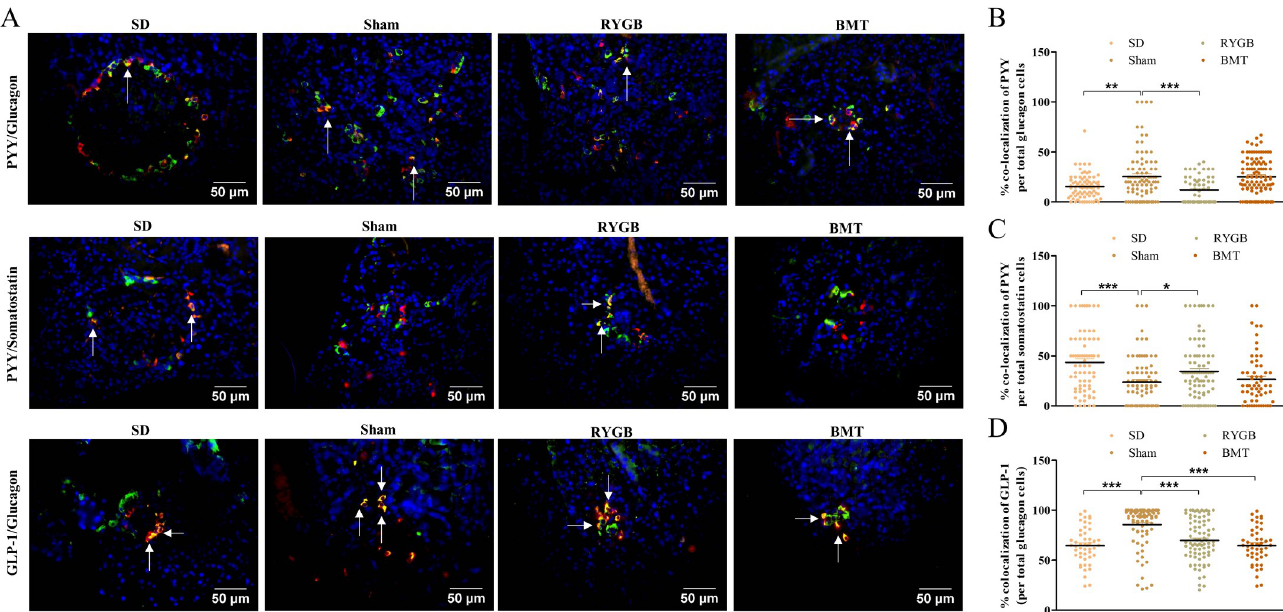
Fig 8. Effects of RYGB, BMT and sham surgery on gut hormone co-localization in islets 8 weeks post-experimental intervention. (A) Representative islet images showing PYY (red) with glucagon & somatostatin (green), GLP-1 (red) with glucagon (green). Nuclei are demonstrated using DAPI staining (blue). Quantification of co-localization of PYY with (B) glucagon and (C) somatostatin, and (D) GLP-1 with glucagon are also shown. Arrows indicate cells that are positive for both PYY and glucagon or somatostatin, and GLP-1 with glucagon. Normal SD rats are included for comparison. Values are mean ± SEM (n = 4) with statistical significance evaluated using one-way ANOVA. � p < 0.05, �� p < 0.01, ��� p < 0.001 compared to sham rats. Analyses carried out on 60–80 islets per group.